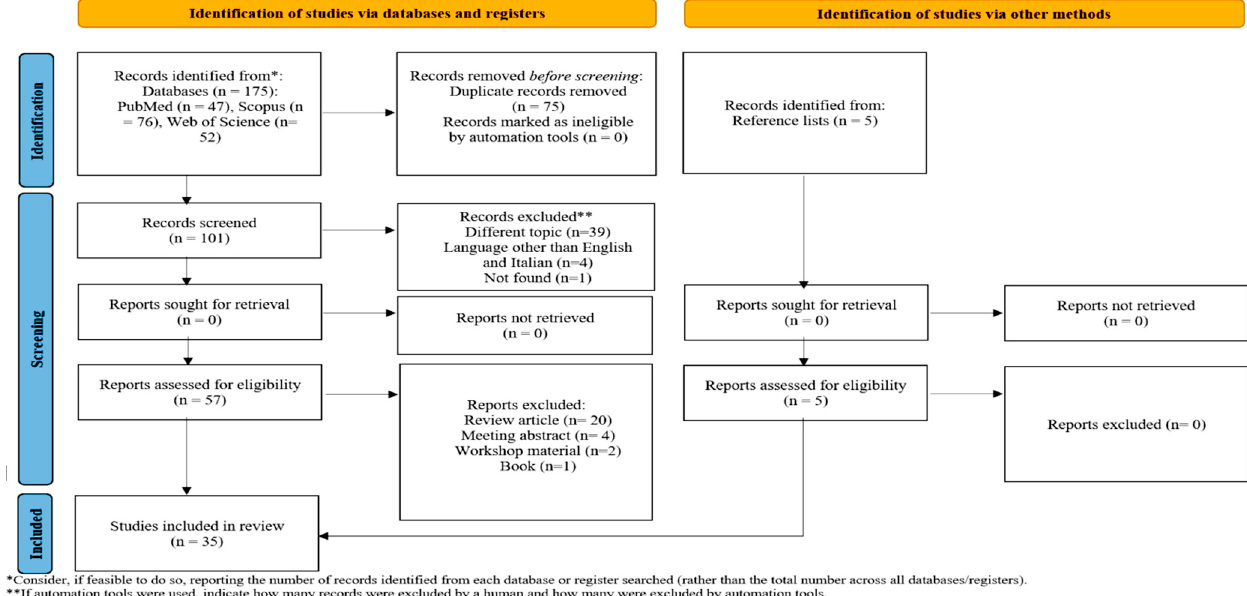
Figure 1. PRISMA flow chart of the review process.